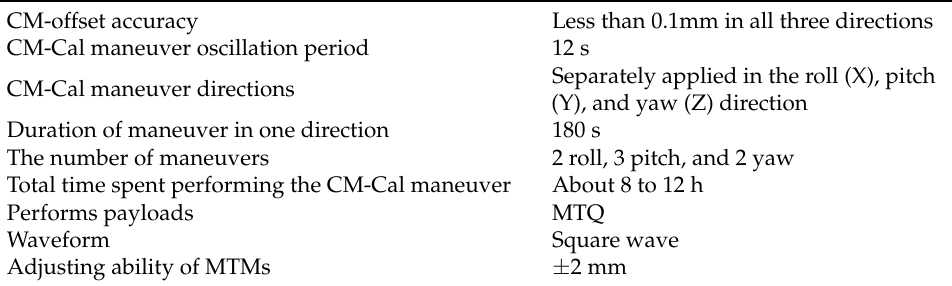
Table 2. GRACE-type satellites CM-Cal maneuver